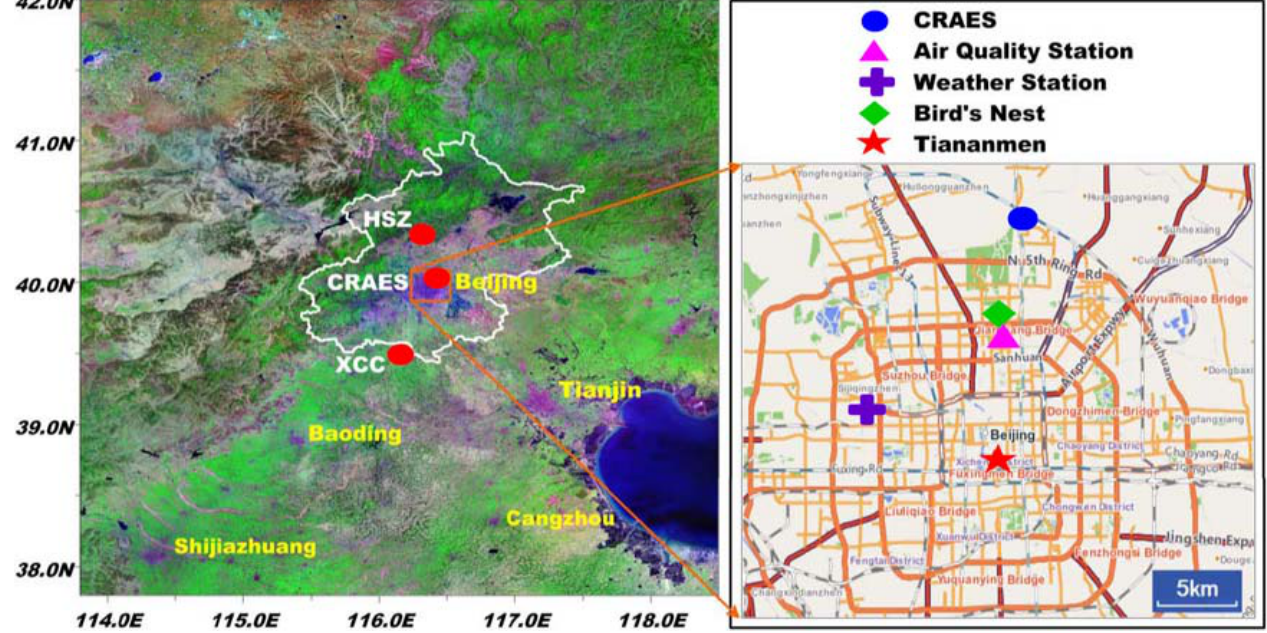
Fig. 1. Map showing the three measurement sites (XCC, CRAES, HSZ), the Beijing Municipality (the area within the white line), and the surrounding regions. Also shown are the location of the “Bird’s Nest” National Olympic Stadium, a Beijing Municipal Environmental Protection Bureau’s air quality station and a Beijing Municipal Meteorological Bureau’s weather station whose data are used in this study.